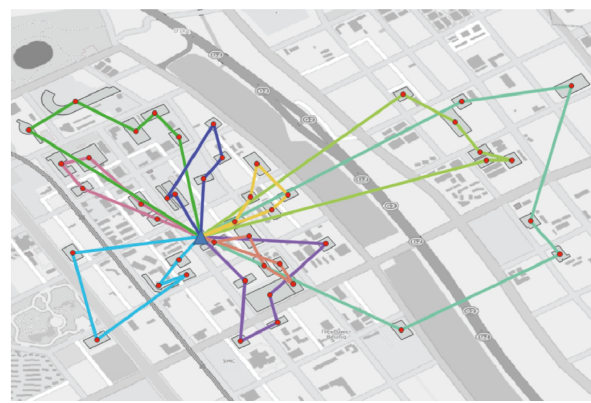
Figure 13: Initial routing plan for Case 1 (45 physical